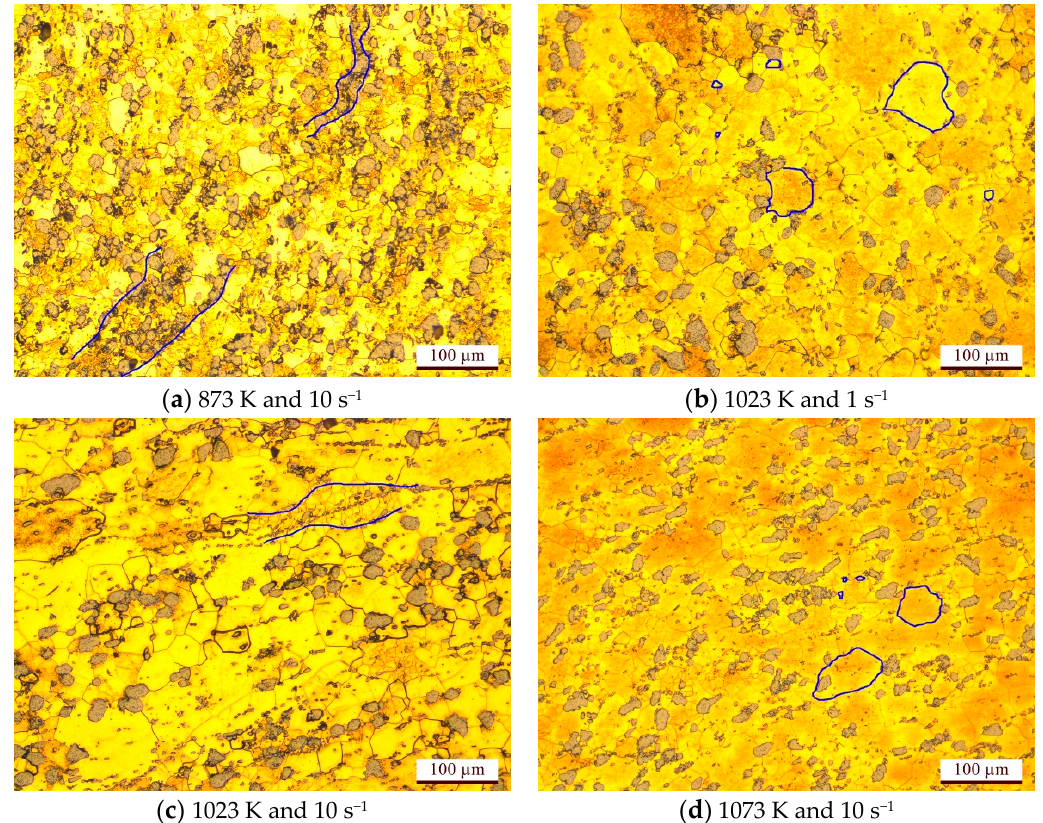
Figure 12. OM images of Cu-Ni-Al brass in the instability region after deformation.